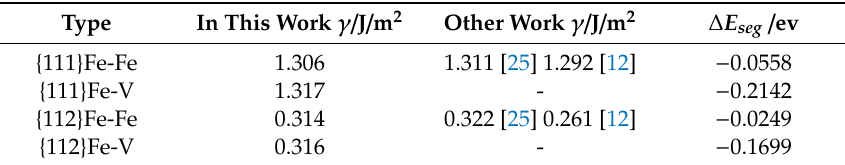
Table 1. {111} and {112} grain boundaries γ and Cu atoms ∆ E seg .